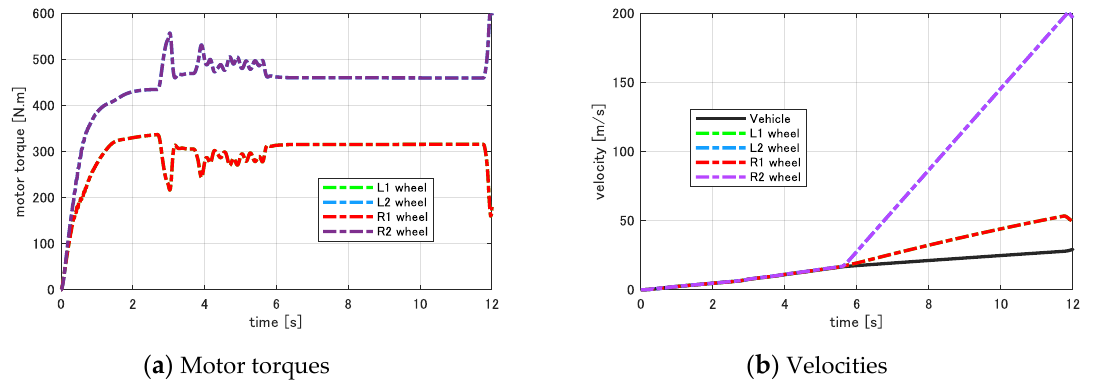
Figure 15. Simulation results of Case 1: without anti-slip control.